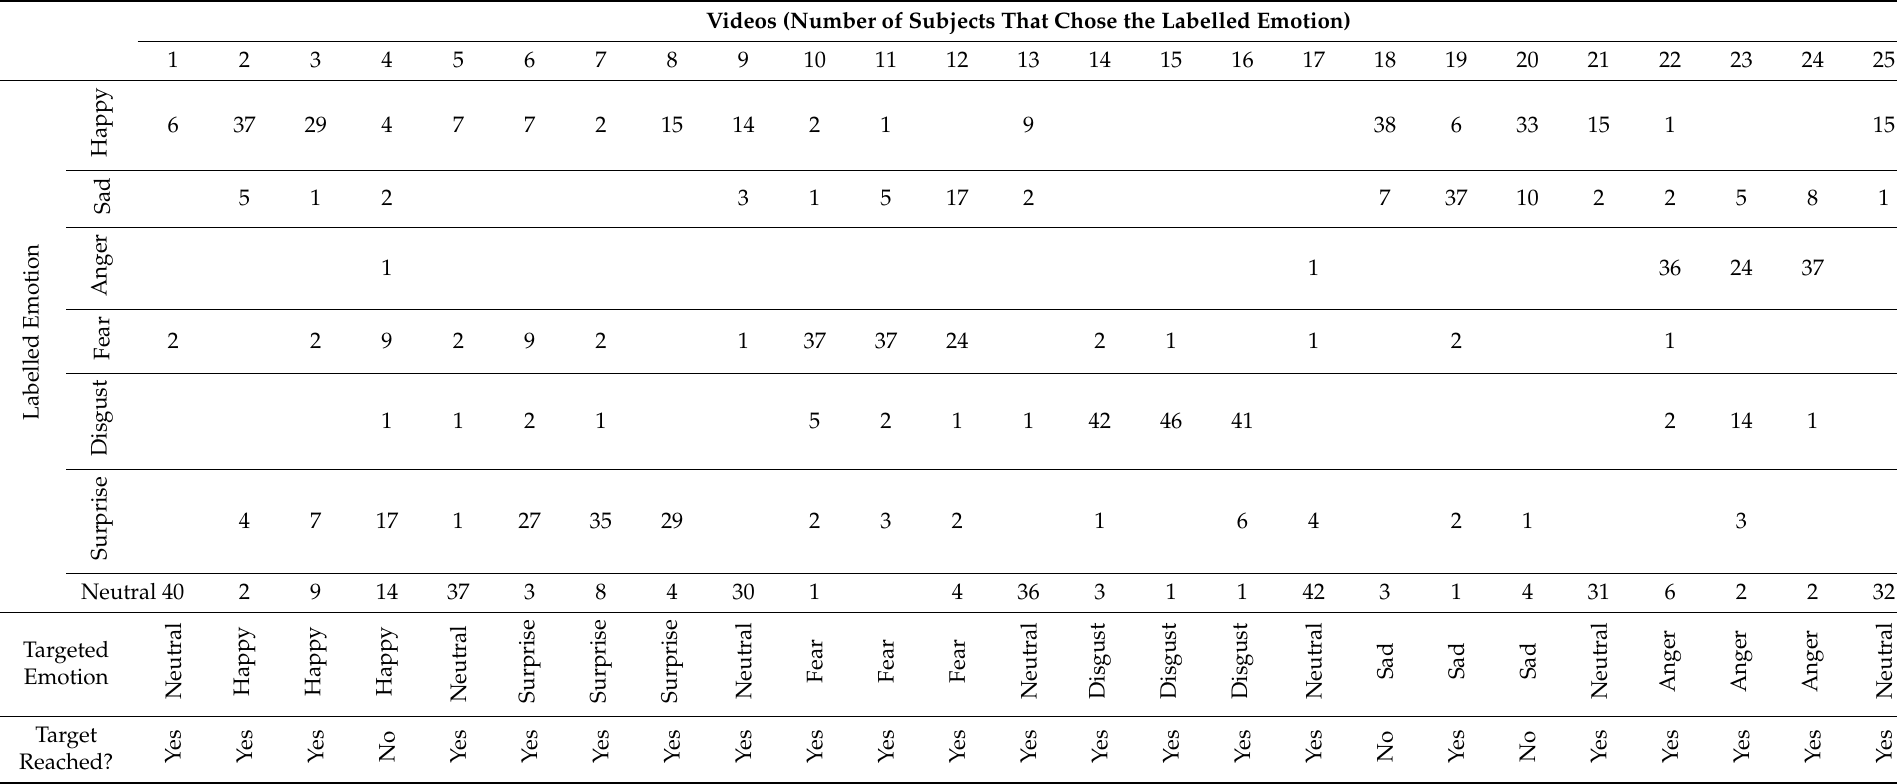
Table 2. Number of subjects that labelled the videos according to the discrete emotional